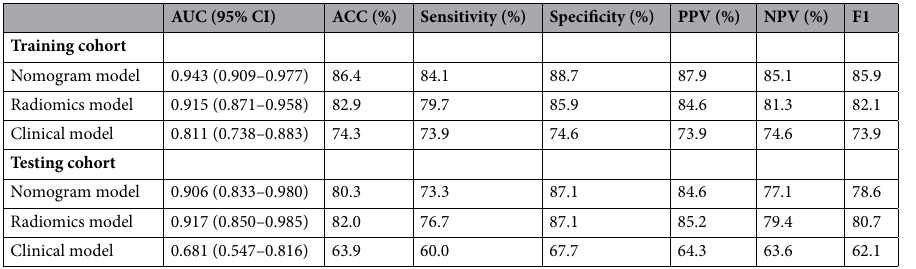
Table 2. Performance of the three models. AUC, area under the receiver operating characteristic curve; ACC, accuracy; PPV, positive predictive value; NPV, negative predictive value.